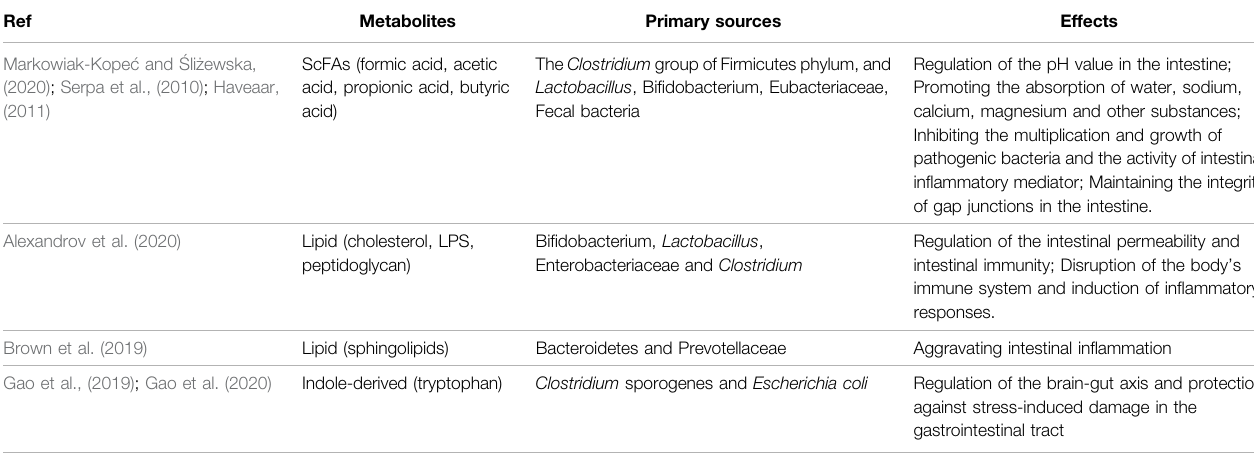
TABLE 2 | Studies of gastrointestinal microbiota metabolites and their